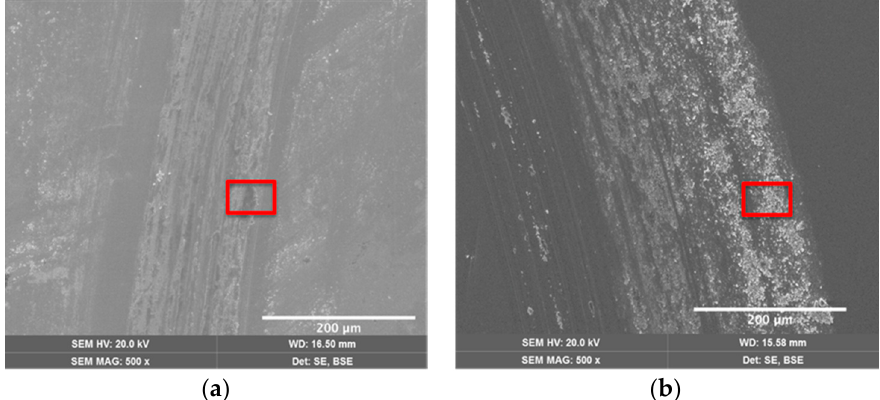
Figure 9. SEM images of wear tracks of coatings deposited in inert atmosphere: ( a ) sample Ar0Ag; ( b ) sample Ar4Ag.